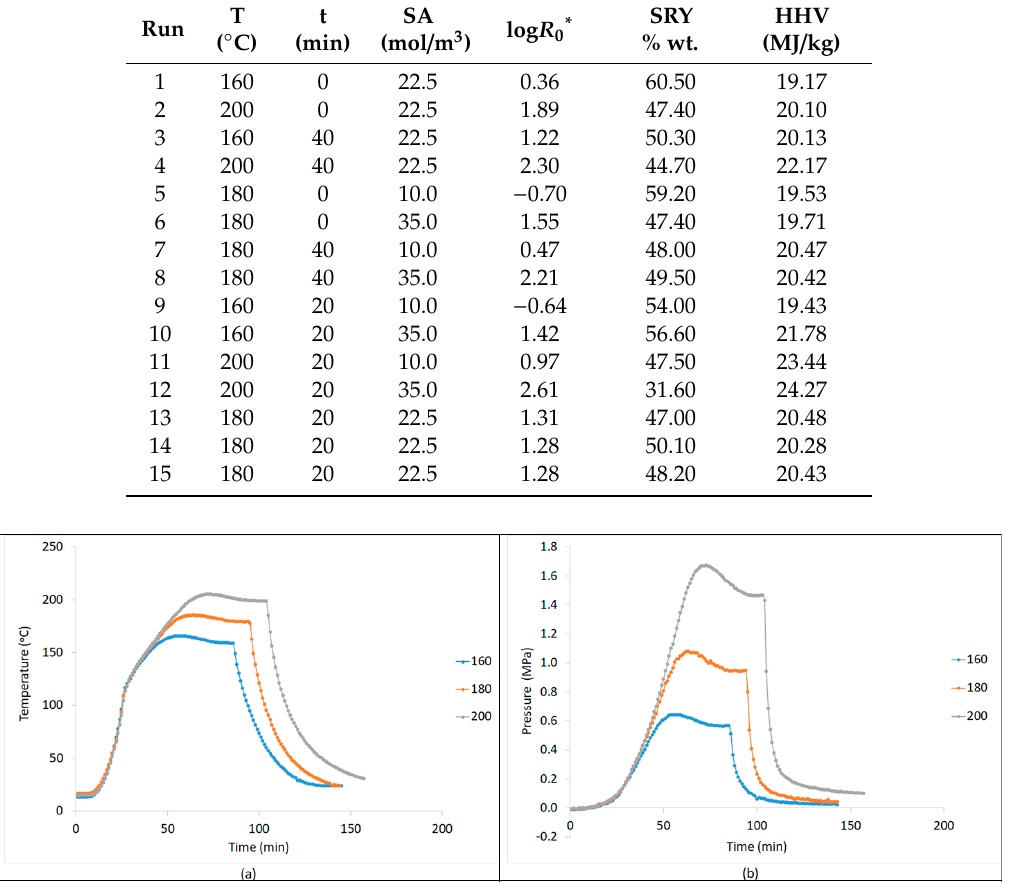
Table 2. Combined severity factor (CSF) in logarithmic form (log R 0* ), higher heating value (HHV) and solid residue yield (SRY) of barley straw treated by acid-catalyzed wet torrefaction (ACWT).